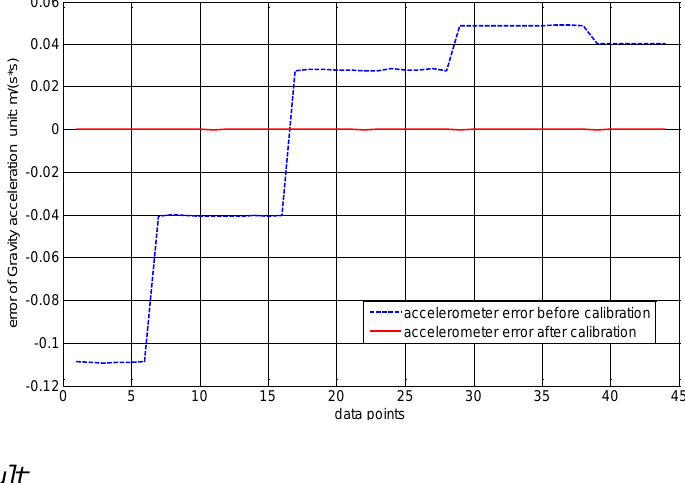
Figure 8a. The red solid line refers to the heading error calibrated by the constant intersection angle method, which is less than ±0.3°, and the blue dashed line refers to the heading error calibrated by the classical ellipsoid fitting method, which is within the range of